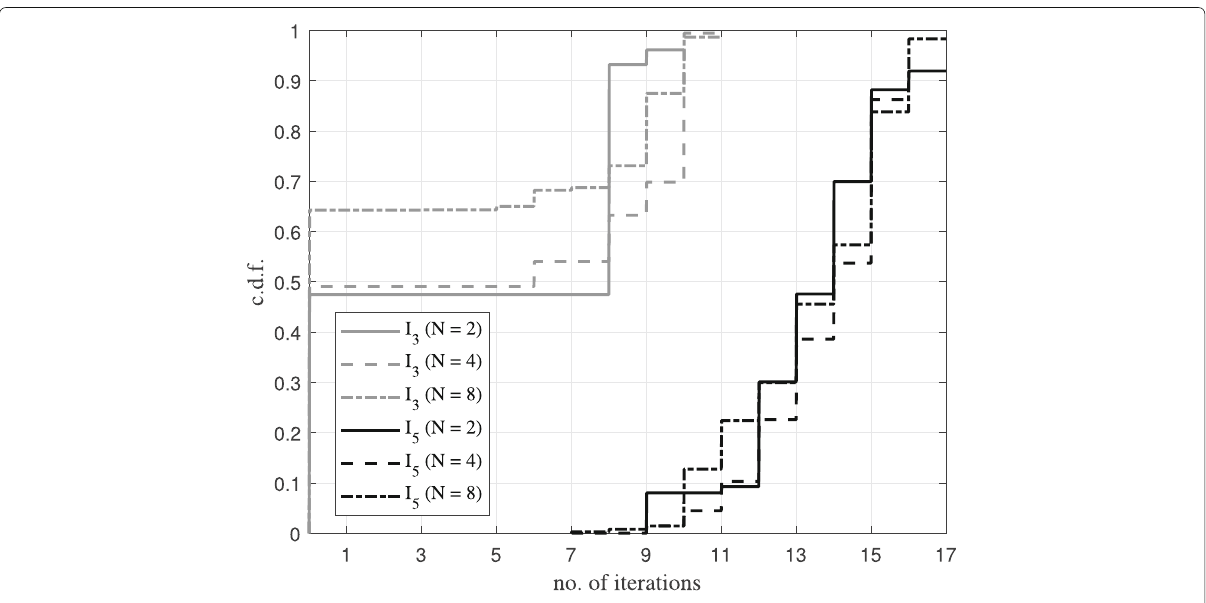
Fig. 6 Cumulative density function (c.d.f.) of I 3 and I 5